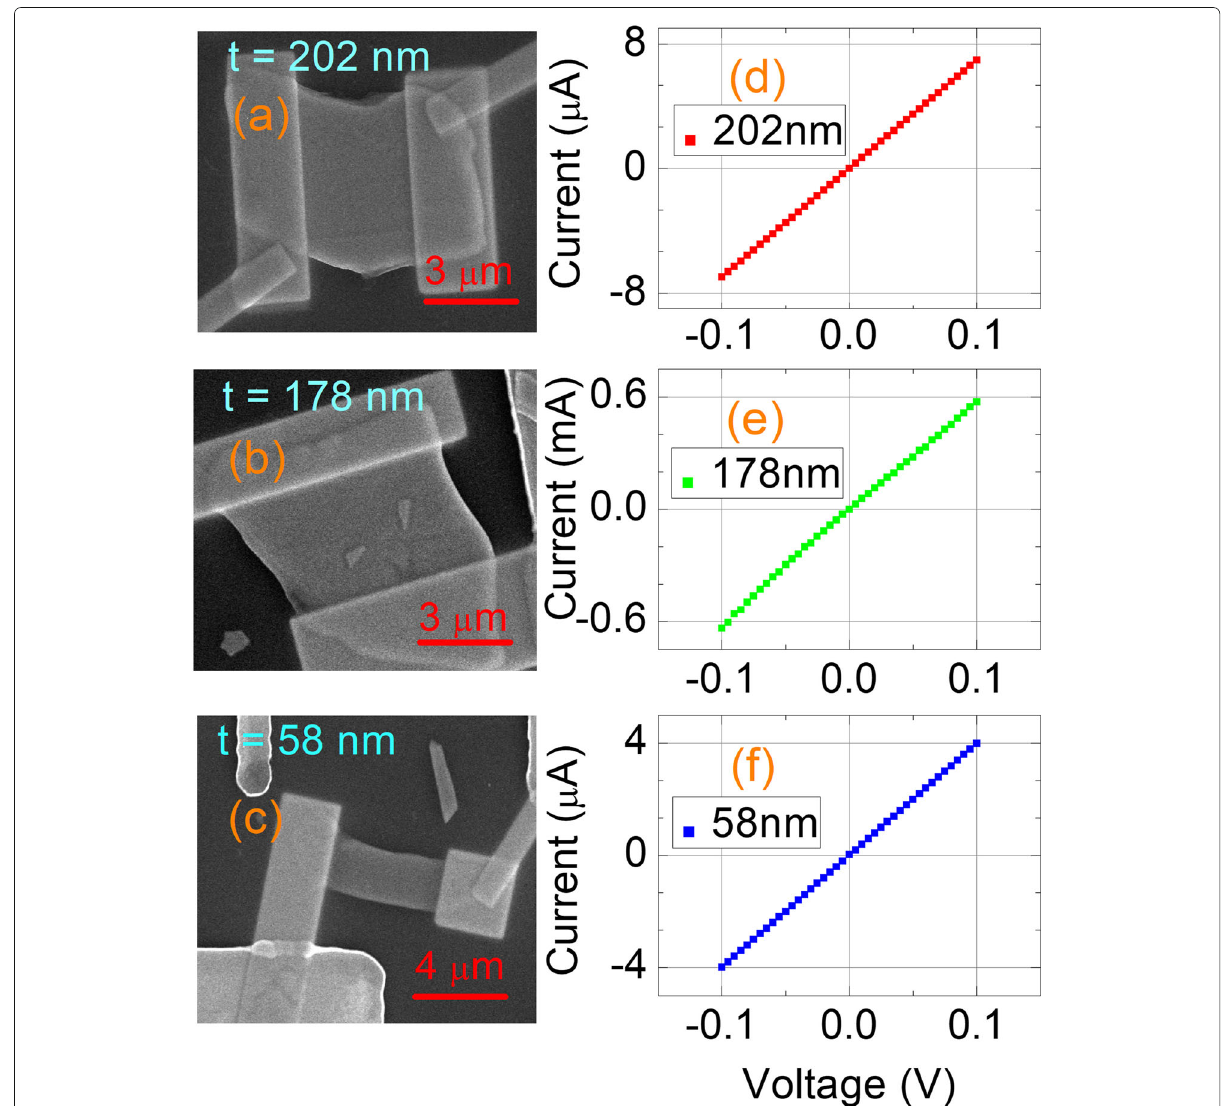
Fig. 1 a , b , and c show the SEM pictures of three Sb 2 Se 2 Te nanosheets. The nanosheet thickness is measured by AFM. Two Pt contacts were deposited on a nanosheet to measure the photocurrent. d , e , and f reveal the voltage-current relation, and it is linear. That indicates the ohmic contact between the Pt electrodes and Sb 2 Se 2 Te nanosheets